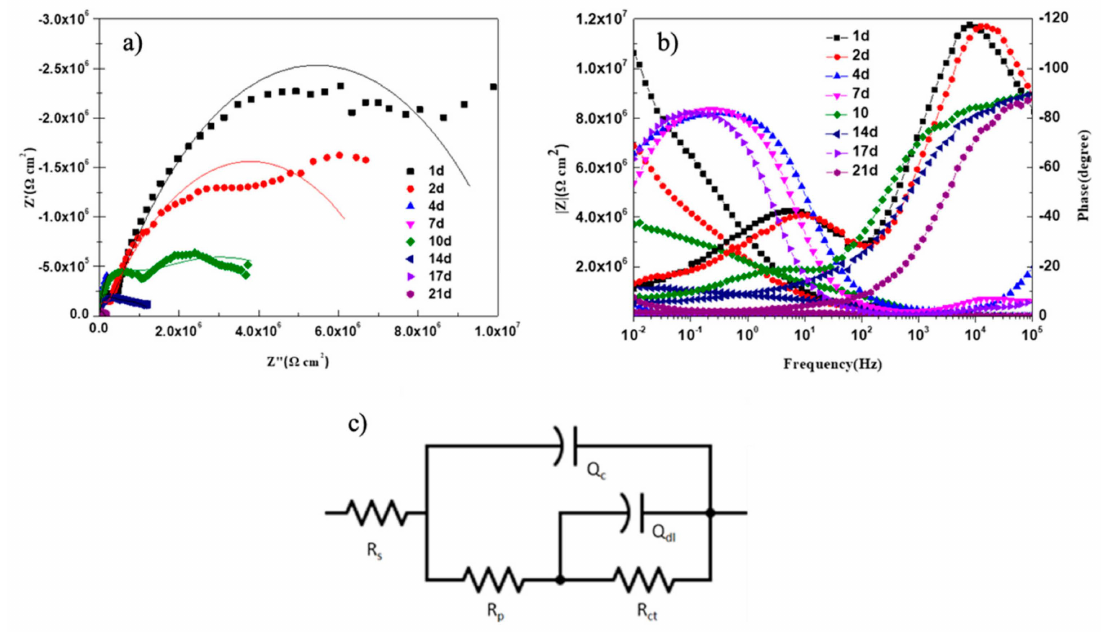
Figure 4. EIS Nyquist plot ( a ) and bode plot ( b ) of the obtained 7075 aluminum alloy on SRB seawater. The figure below demonstrates the equivalent circuits applied to fit EIS plots ( c